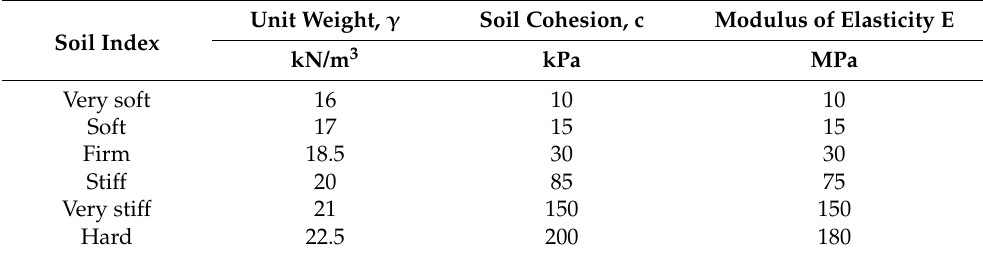
Table 4. Clay parameters used in FEM model.